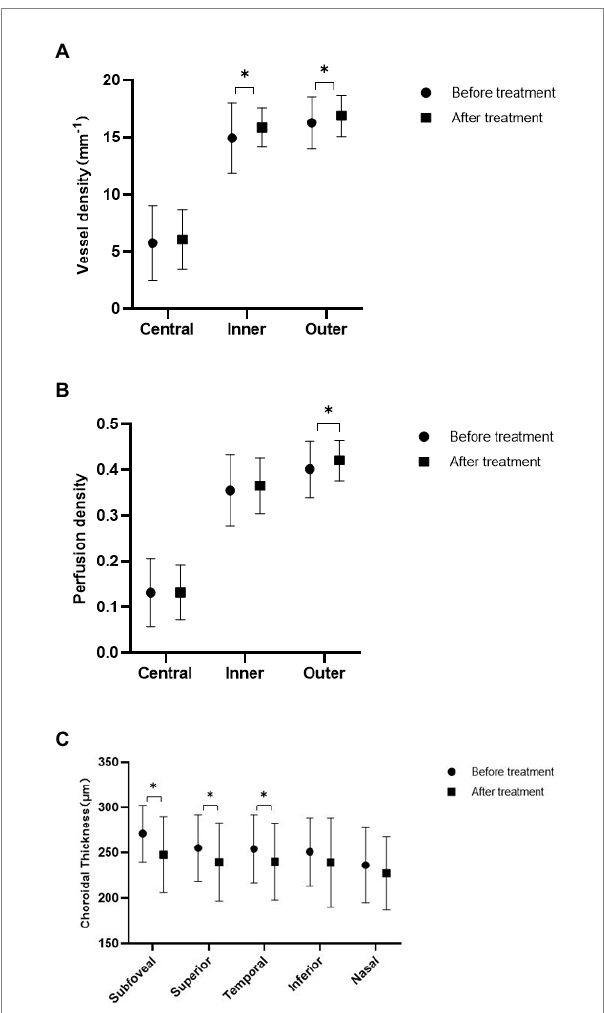
FIGURE 2 Comparison of acute myeloid leukemia (AML) patients before and after treatment. (A) Three zones of macular vessel density before and after treatment. (B) Three zones of macular perfusion density before and after treatment. (C) Choroidal thickness at five measurement points before and after